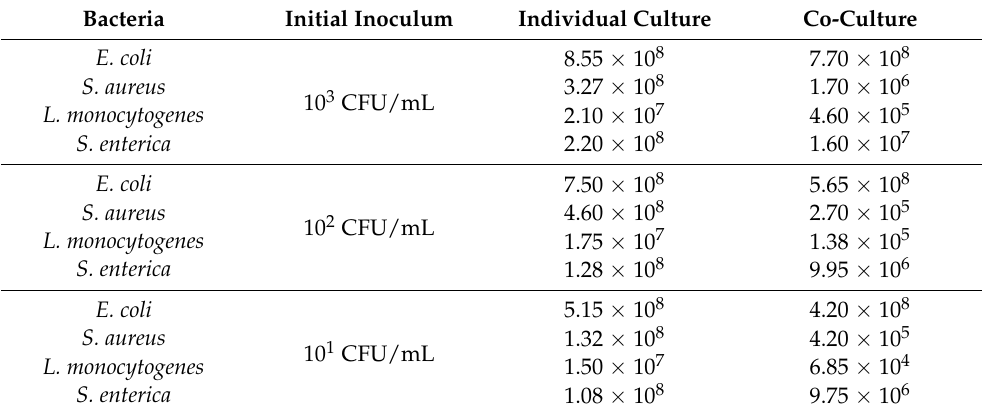
Table 3. Recovery rates values in CFU/mL from individual and co-culture growths in